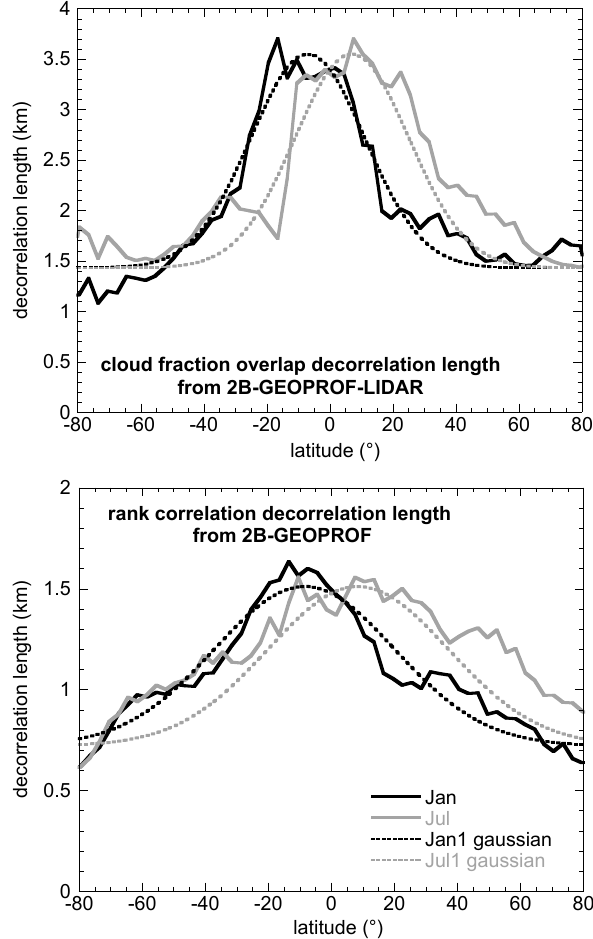
Fig. 1. (top): Cloud fraction overlap decorrelation lengths from 3 ◦ zonal averages of α ( 1z ) for January and July 2009 (solid curves) derived from the 2B-GEOPROF-LIDAR CloudSat product; the dashed curves correspond to gaussian fits according to Eqs. (10) and (11). (bottom): As top panel, but for rank correlation decorrelation lengths calculated from CloudSat 2B-GEOPROF CPR